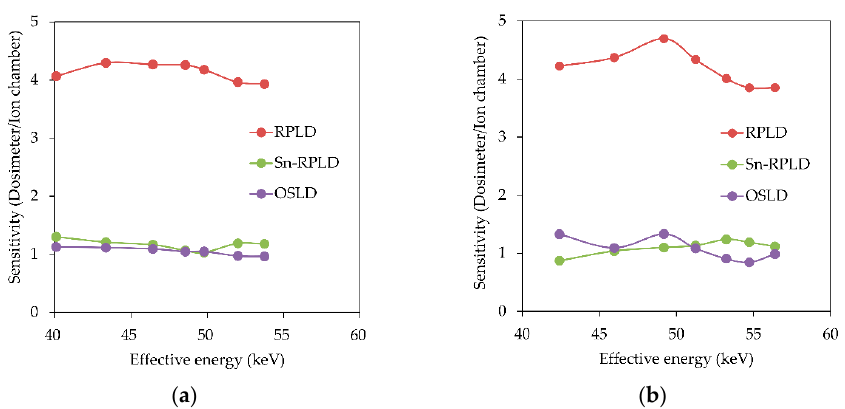
Figure 6. Sensitivity of small dosimeters as a function of effective energy: ( a ) additional filter of 0.2 mmCu and ( b ) additional filter of 0.3 mmCu.